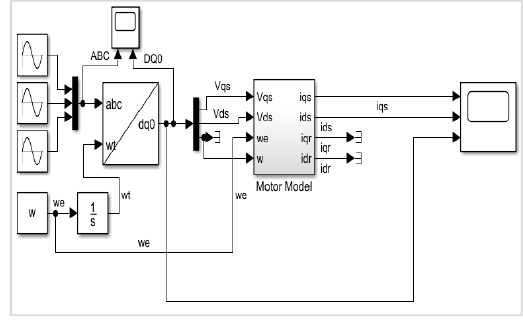
Figure 11. Equivalent circuit of the locked rotor. Figure 12 illustrates a static model of an induction motor.